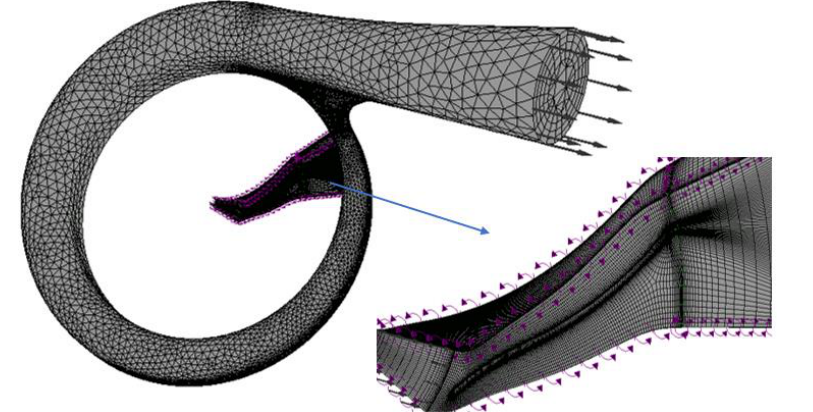
Figure 5. Mesh of impeller, diffuser, and